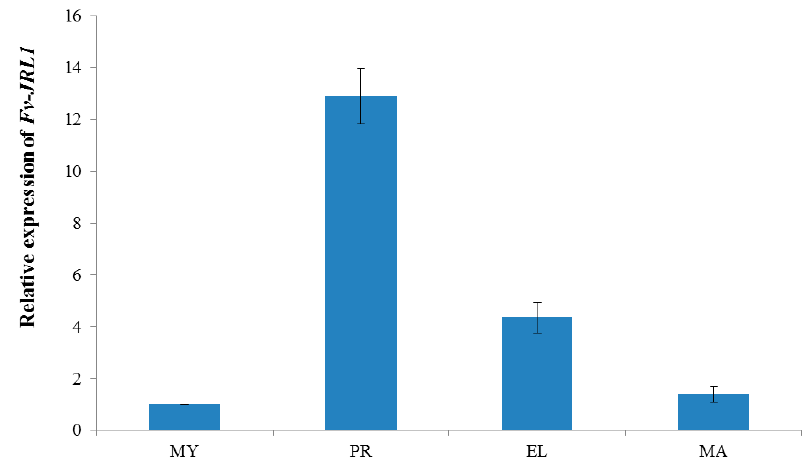
Figure 2. Expression patterns of Fv-JRL1 during different development stages in F. velutipes . MY, mycelium; PR, primordium; EL, elongation stage; MA, mature fruit body.